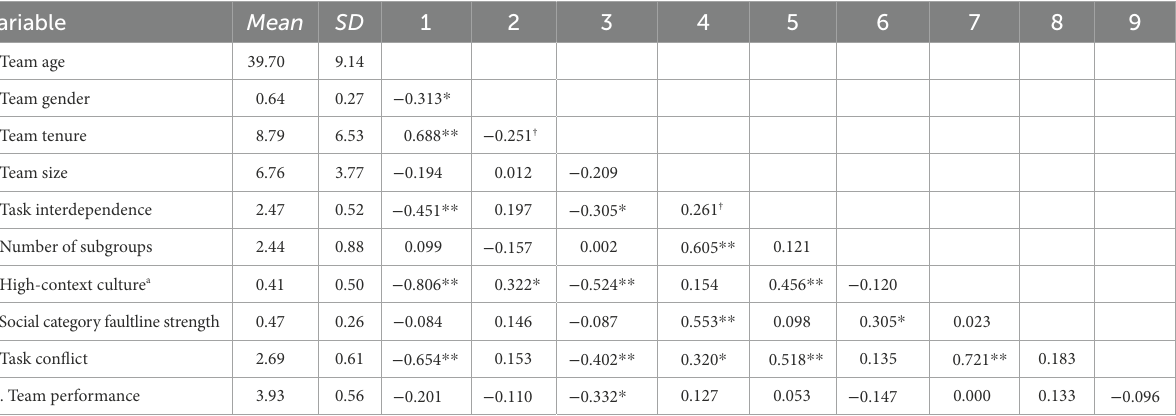
TABLE 1 Means, standard deviations, and correlations.